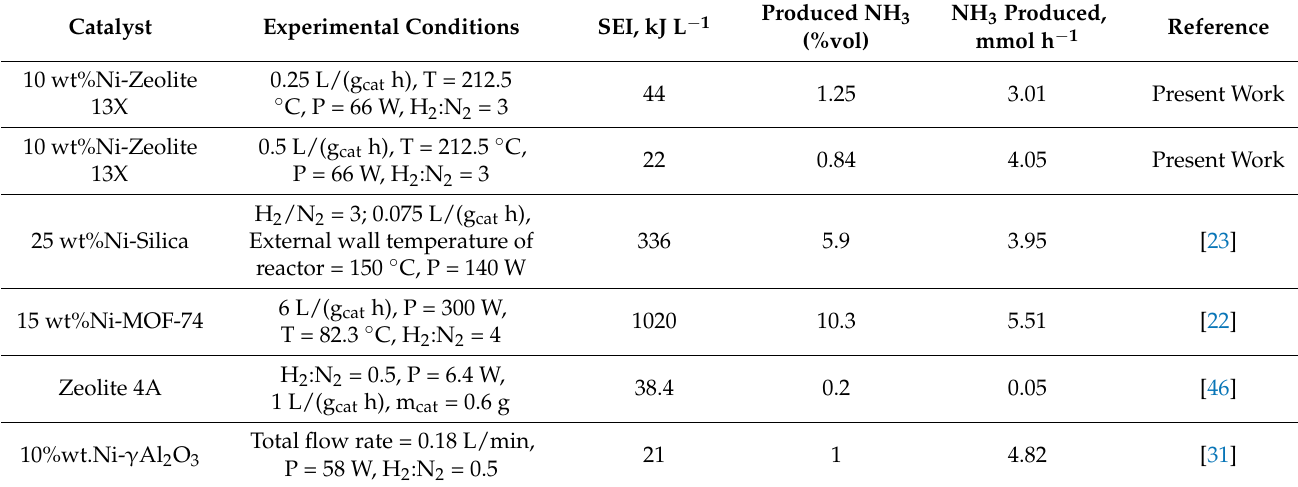
Table 3. Ammonia production and SEI comparison in packed DBD